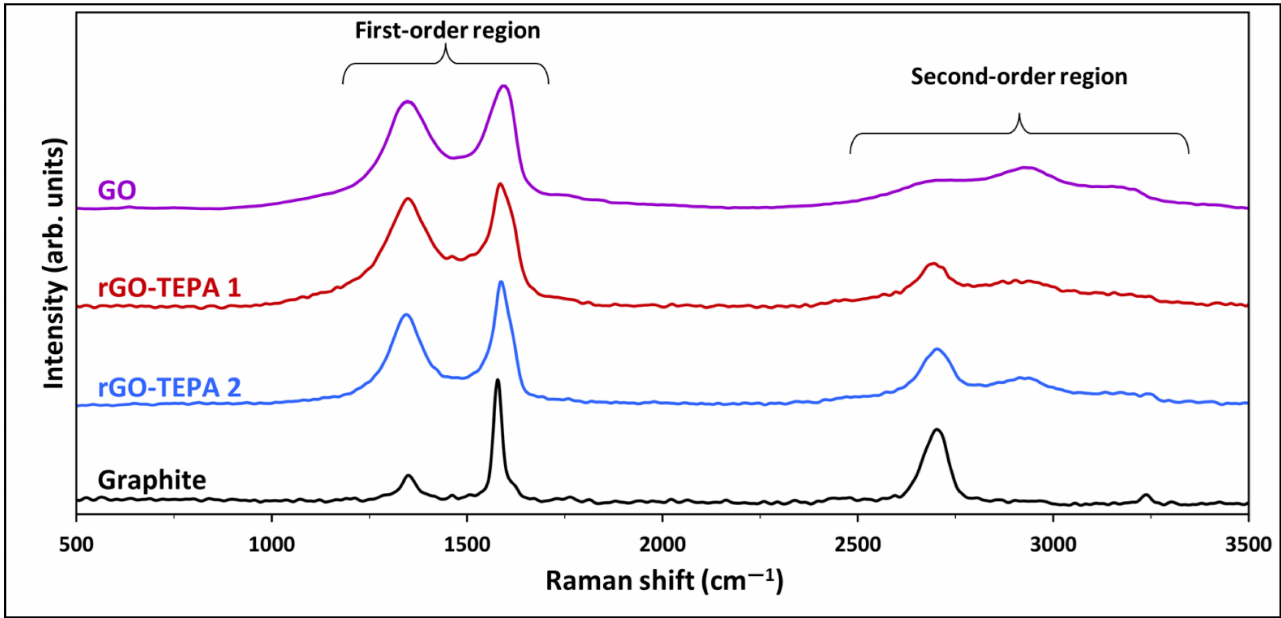
Figure 3. Raman spectra of the graphite, pristine GO, and rGO-TEPA1 and rGO-TEPA2 nanohybrids. The spectra were normalized by their highest intensity for